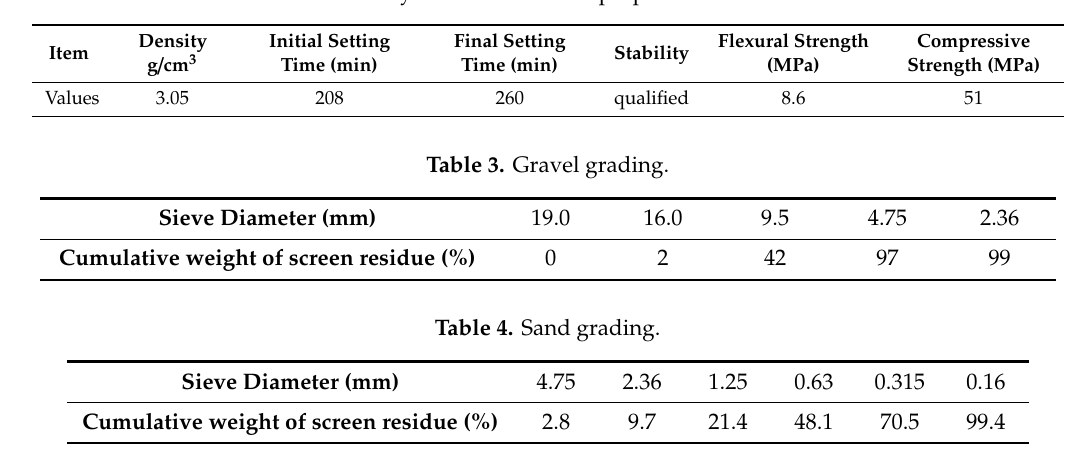
Table 2. Physical and chemical properties of cement.